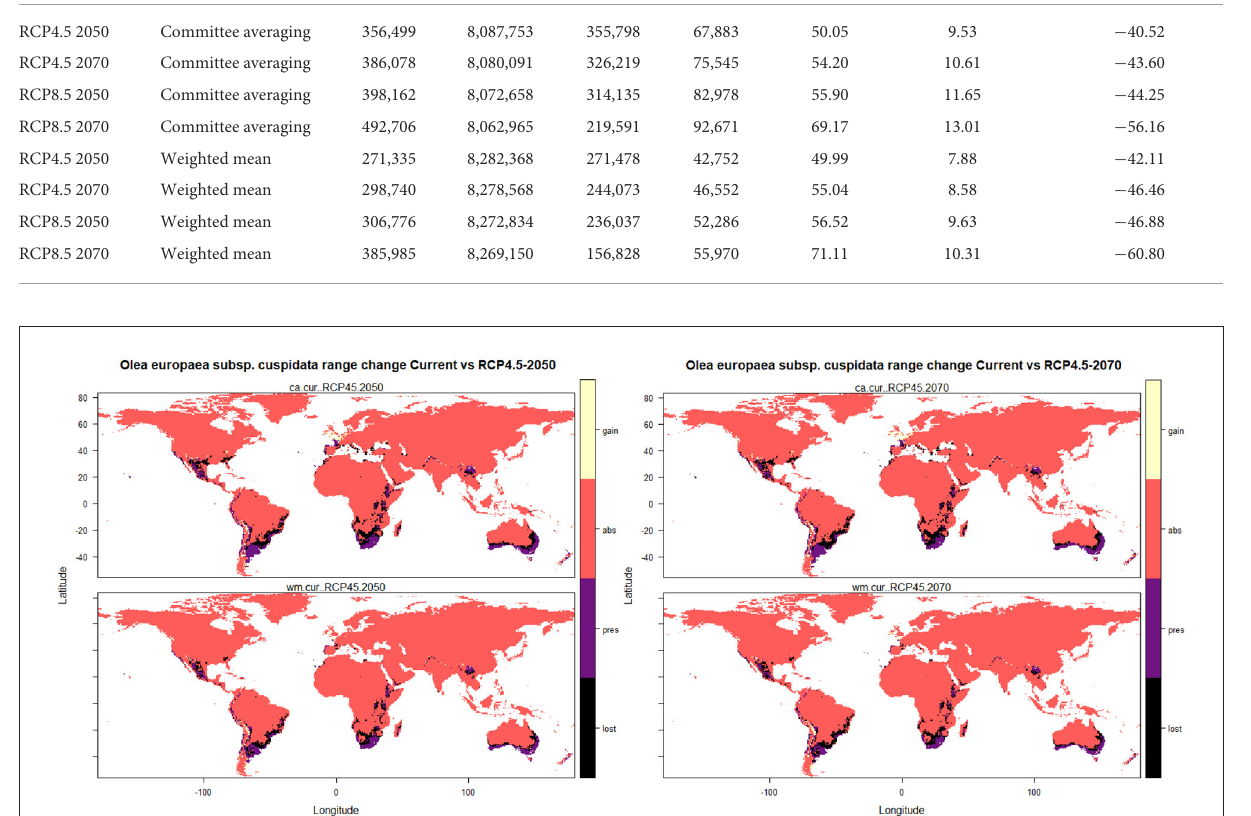
Olea europaea subsp. cuspidata were 0.991 and 0.913 for committee averaging and 0.992 and 0.908 for weighted mean, respectively. The consistent results obtained prove the model’s improved